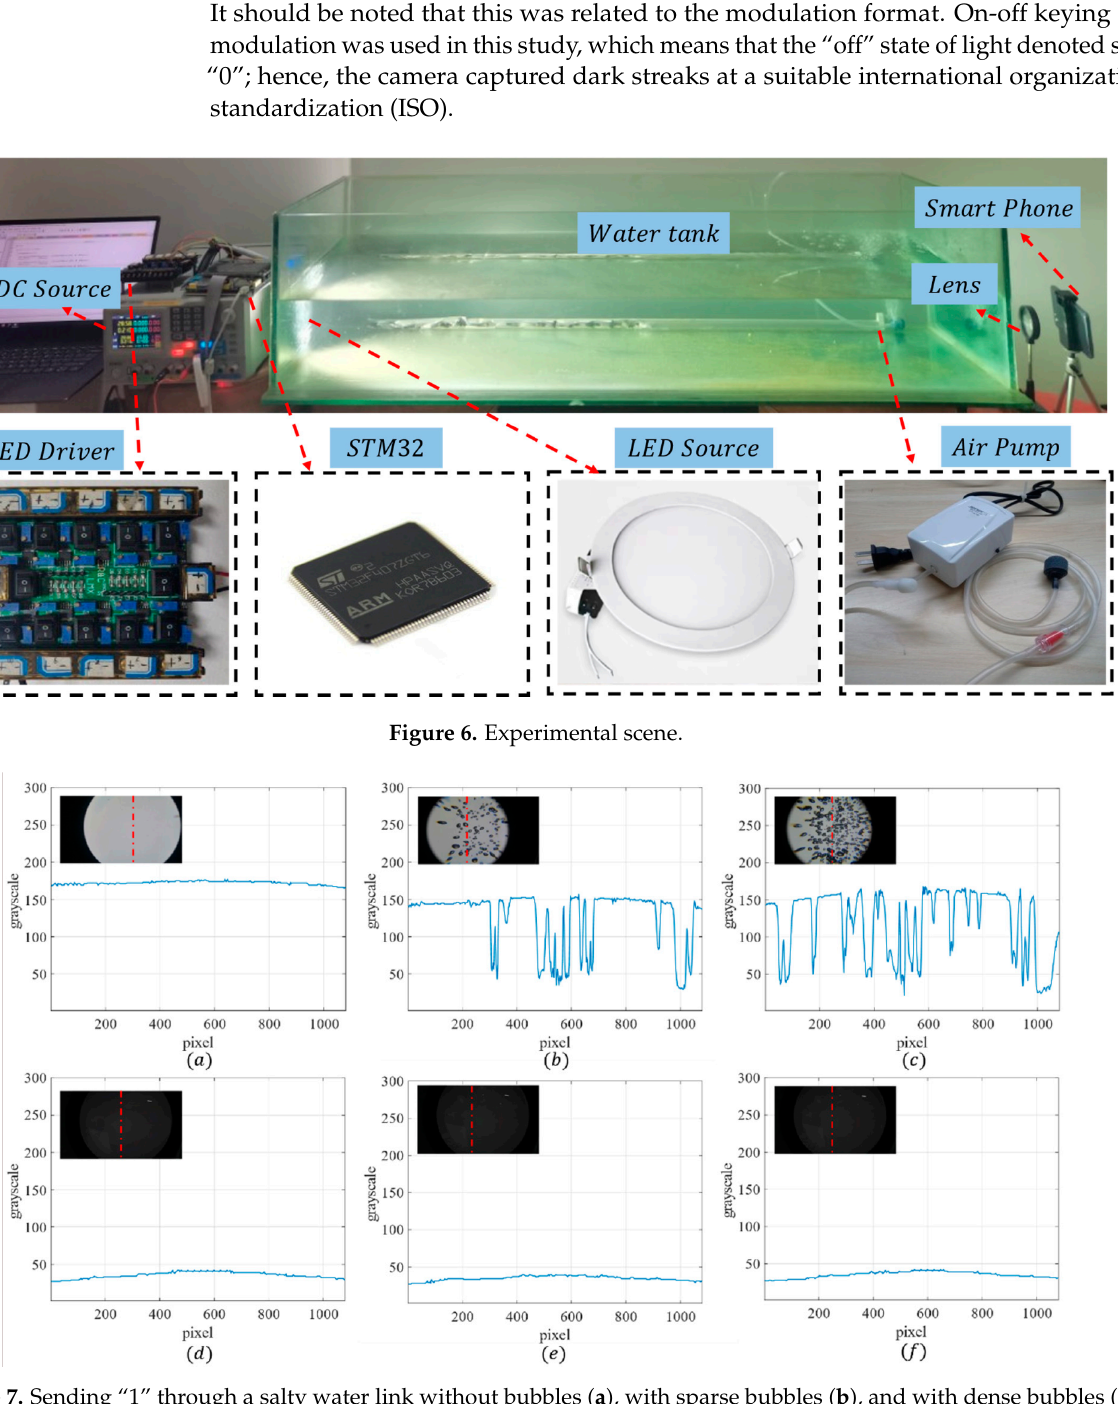
Figure 7. Sending “1” through a salty water link without bubbles ( a ), with sparse bubbles ( b ), and with dense bubbles ( c ). Sending “0” through a salty water link without bubbles ( d ), with sparse bubbles ( e ), and with dense bubbles ( f